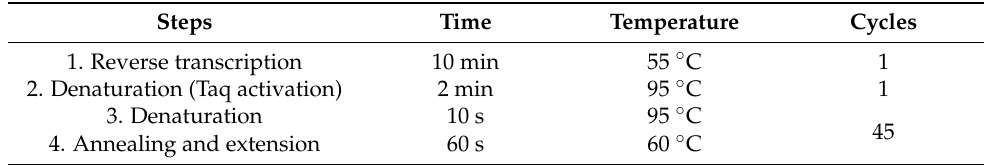
Table 1. Amplification steps following recommendations for genesig ® Real-Time PCR Assay (Primerdesign, Camberley,